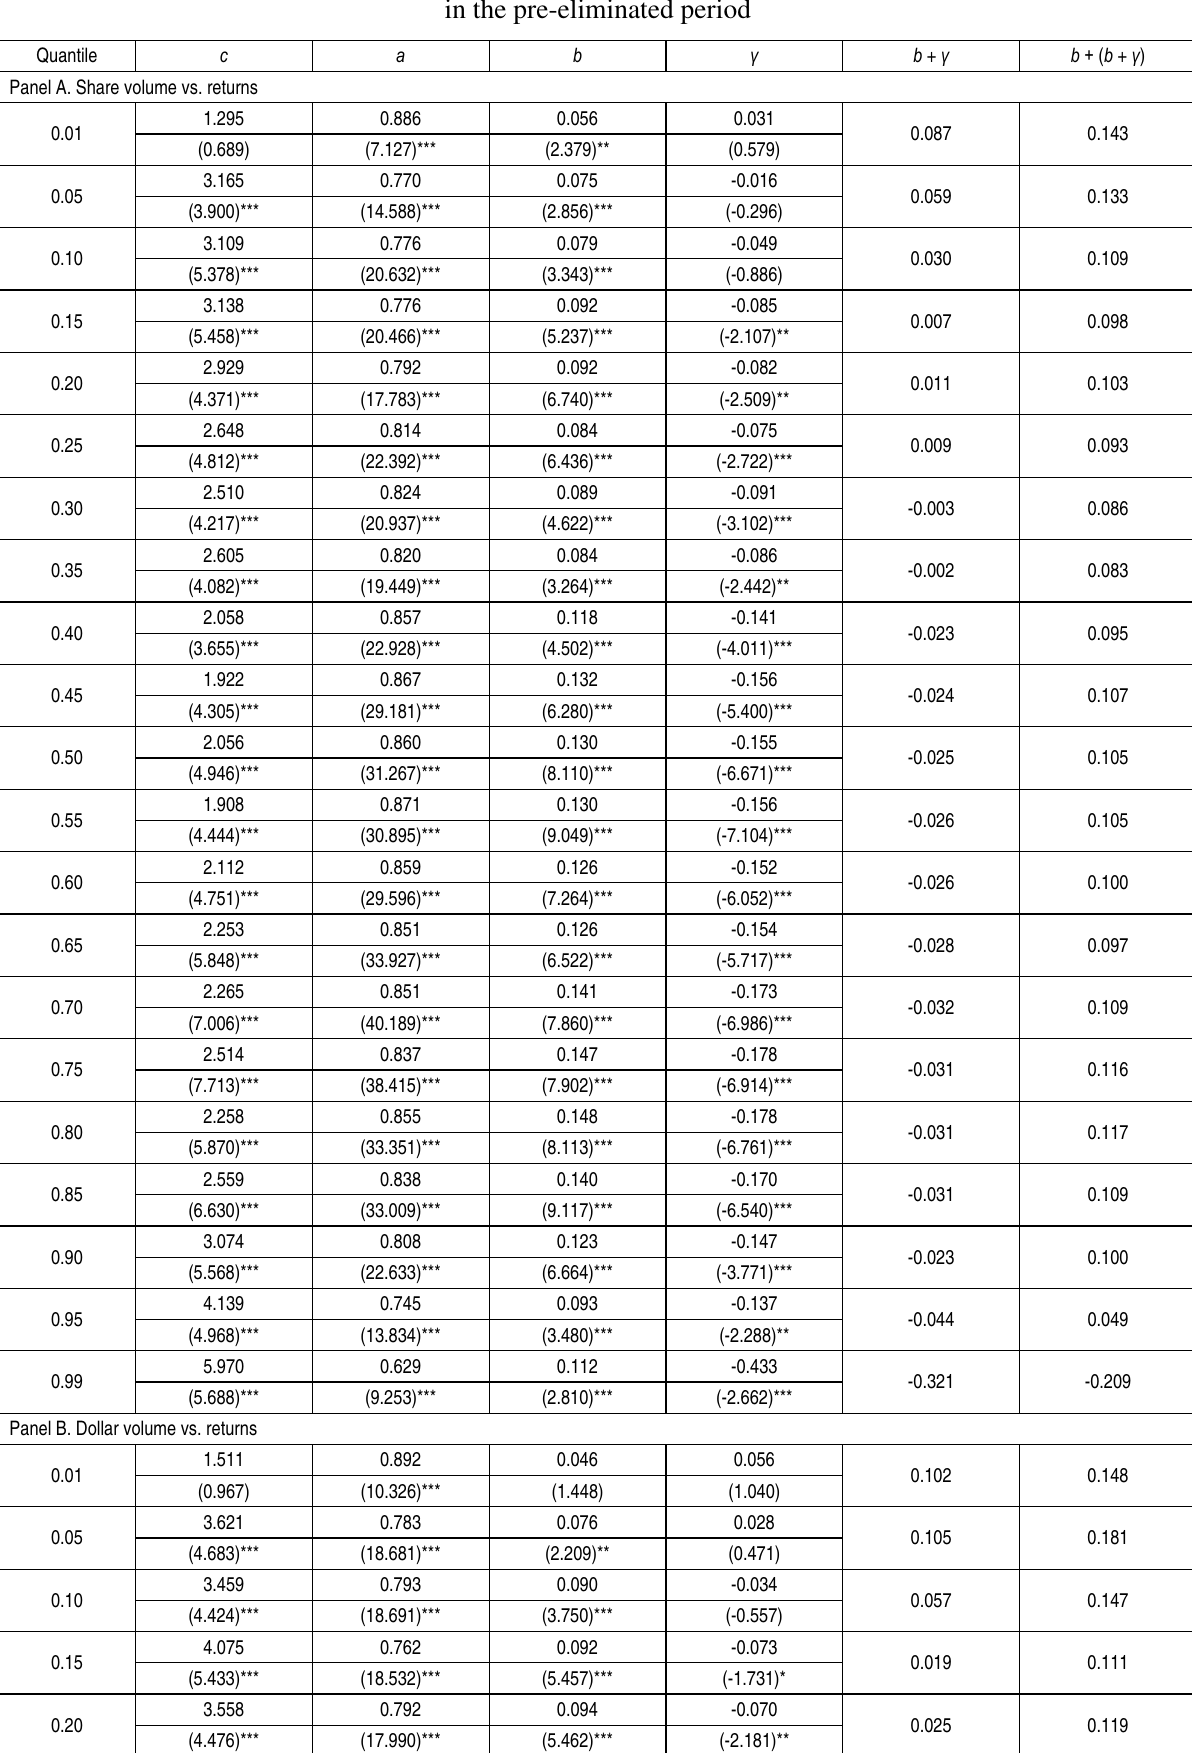
Table 6. Quantile regression estimates of volume-signed return correlation for TAIEX in the pre-eliminated